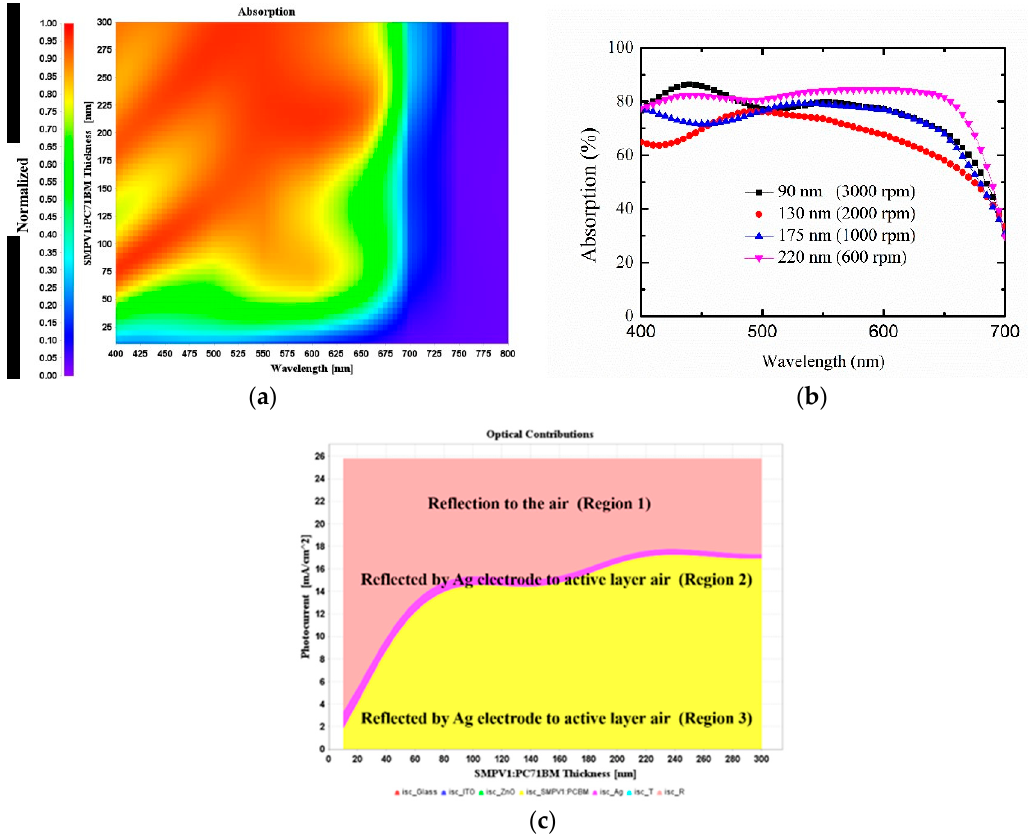
Figure 2. ( a ) Simulated absorption spectra of the devices with the various thicknesses of active layer. ( b ) The absorption spectra of the devices with various active layer thicknesses. ( c ) Optical contribution by each layer.